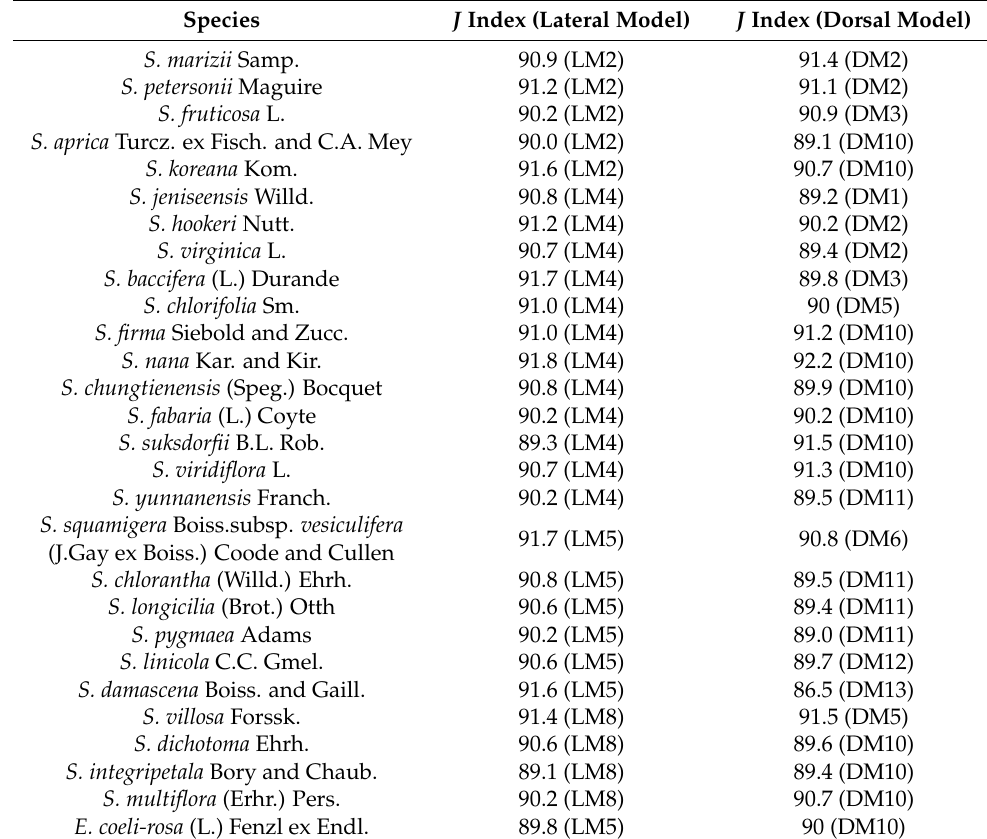
coeli-rosa and 27 species of Silene . Table 1. Best scores obtained in lateral and dorsal models for each species of Silene, based on mean values of 20 seeds. Values of J index superior to 89.0 for the lateral and dorsal views are shown, except S. damascena for the dorsal model DM13.